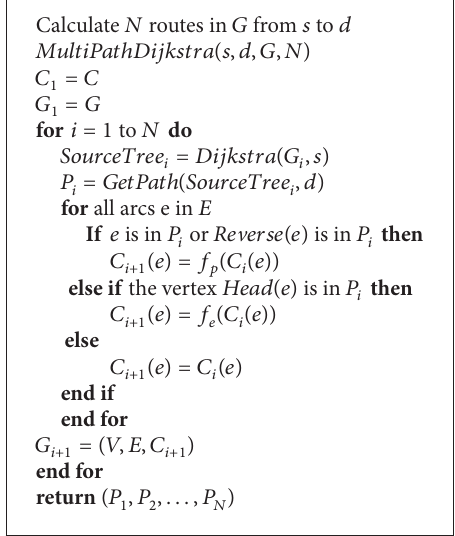
Algorithm 1: The multipath Dijkstra